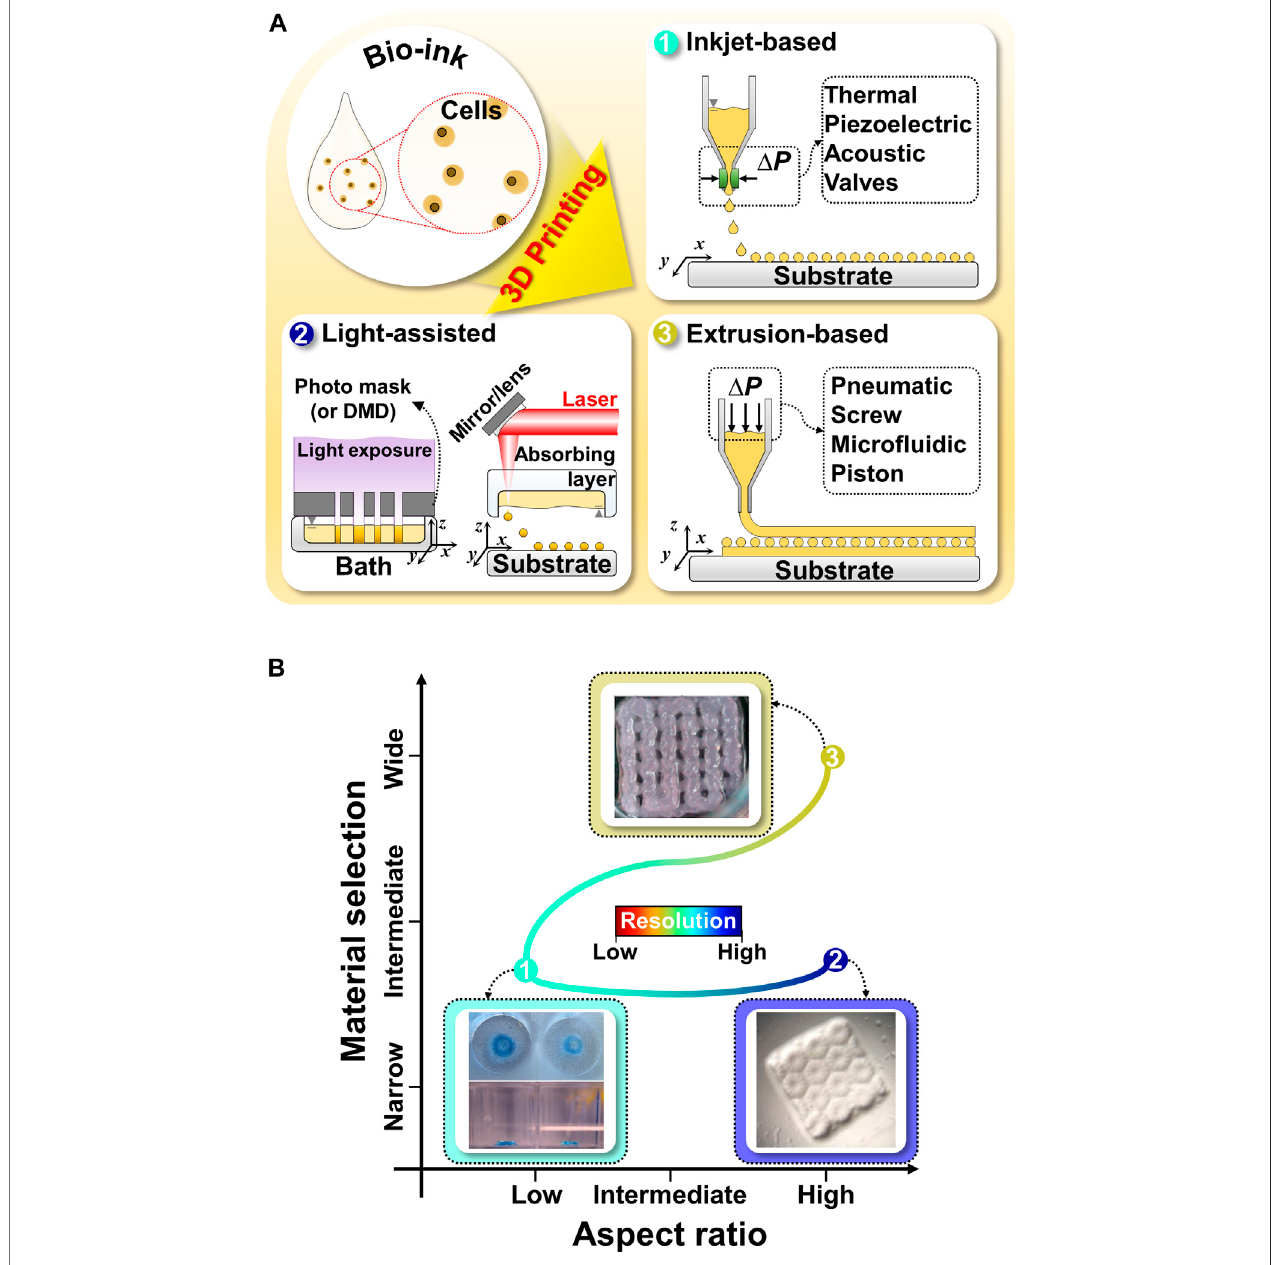
FIGURE 1 | Schematic illustration and comparison of commonly utilized 3D bioprinting techniques for liver tissue engineering (A) Schematic illustration of 3D bioprintingtechniques,suchasinkjet-basedbioprinting,light-assistedprintingsystem,and extrusion-basedbioprinting. (B) Comparison of3Dbioprintingtechniques in terms of material selection, aspect ratio, and resolution. Representative images of inkjet-based, light-assisted, and extrusion-based printing. Reproduced with permission from Faulkner-Jones et al. (2015), Ma et al. (2016), Hiller et al. (2018).